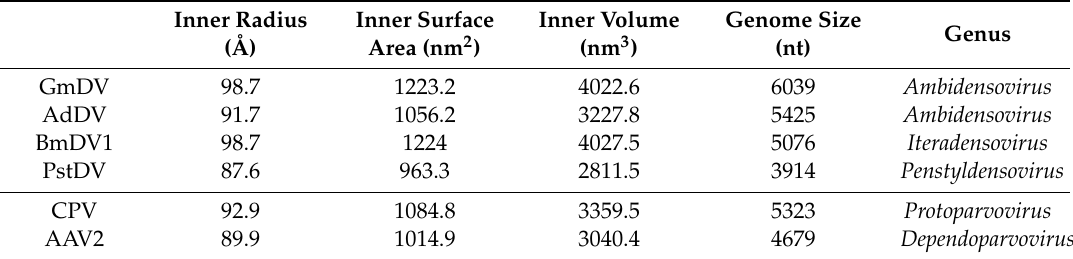
Table 7. Dimensions, DNA content, and taxonomy of densovirus capsid